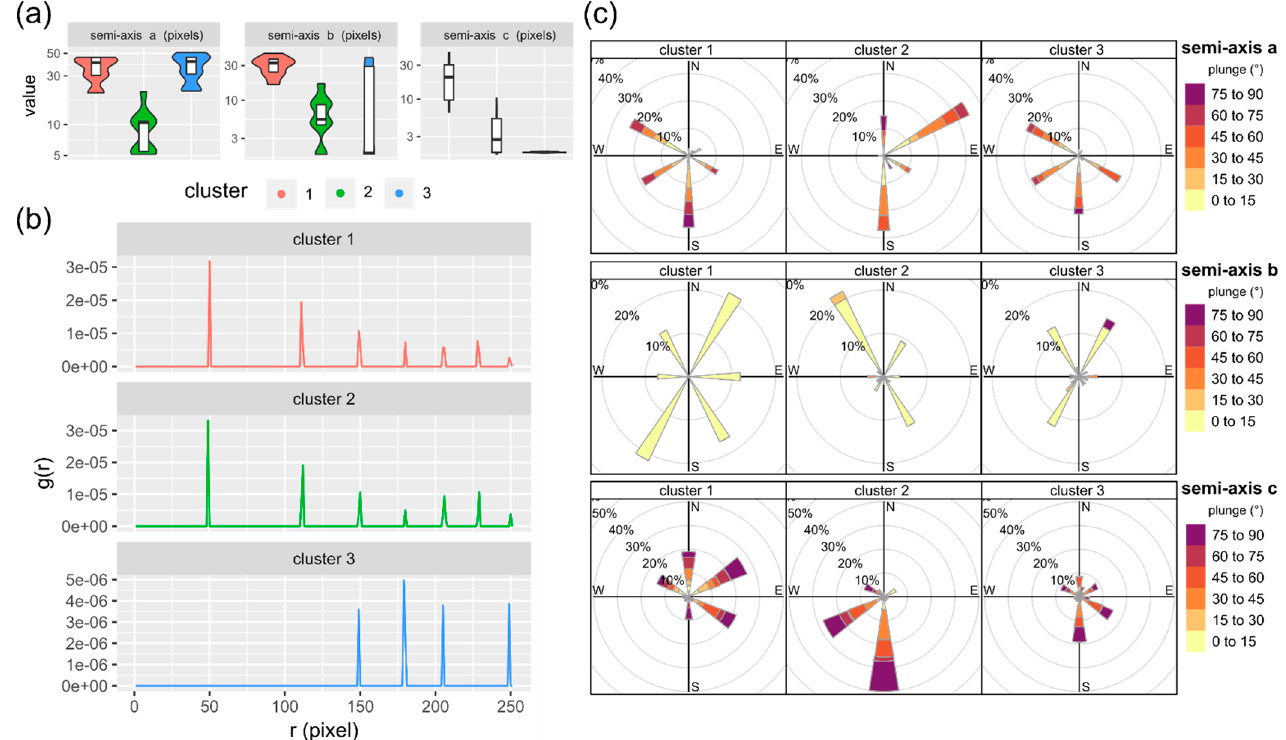
Figure A3. ( a ) Distribution of the selected parameters; ( b ) Radial distribution function g(r) calculated for the geometrical centres of grains; ( c ) Spatial orientation of the grains in the clusters.